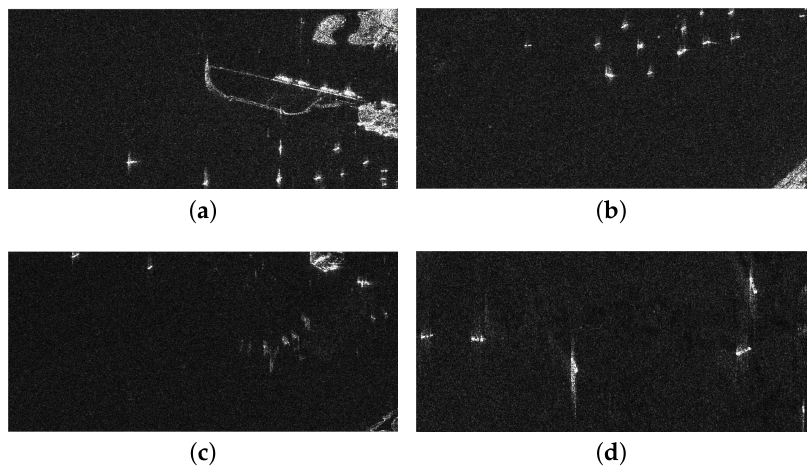
Figure 9. Complex dataset ship slices: ( a , c ) inshore ship slices; ( b , d ) offshore ship slices.